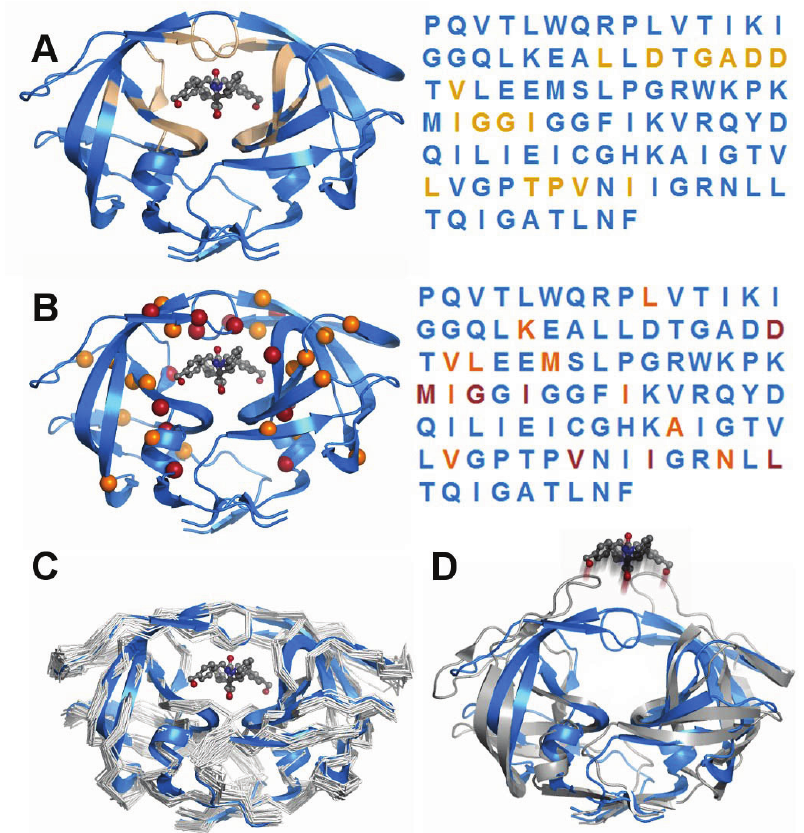
Figure 1. The HIV-1 protease as a generic model system for computational biophysics 14–16 . HIV-1 protease has become a model system because of its disease relevance, the availability of mutational and drug binding data, and for its tractable size and molecular stability. The protein’s function is to cleave HIV peptides into the functional proteins of the infectious HIV virion. This example illustrates generalized concepts of the applicability of protein modeling methods in clinical investigations A) Ligand binding residues are spatially separated . The functional protein dimer is shown with a pharmacologic inhibitor bound to the active site. Residues that are within 3.5Å of the inhibitor are highlighted in tan. The primary sequence is colored identically to the three-dimensional structure to indicate relative positioning of residues. It is apparent that the ligand binding portion of the protease consists of residues that are non-adjacent within the primary sequence, which illustrates an advantage of modelling over linear sequence analysis. B) Drug resistance mutations tend to occur in residues within the active site . Many mutations have been characterized that are associated with resistance to inhibitor drugs. While the sites of these mutations are also disjoint in sequence, nearly all of them fall into the same set of drug binding residues, indicating how modeling can enable prediction of a mutation’s effect. C) Structural effects of mutations beyond the active site . Drug-resistance mutations in non-ligand-binding residues have been shown, using computational experiments, to impact the flexibility of the protein and therefore alter drug binding. Computational modeling has characterized the flexibility of the protein in multiple mutated states, illustrating the potential to predict the functional effect of mutations beyond an active site. D) Dynamics of ligand-free protein . Computational studies have the advantage of being able to simulate conditions that are difficult to assay experimentally, such as the dynamics of ligand-free forms in atomic